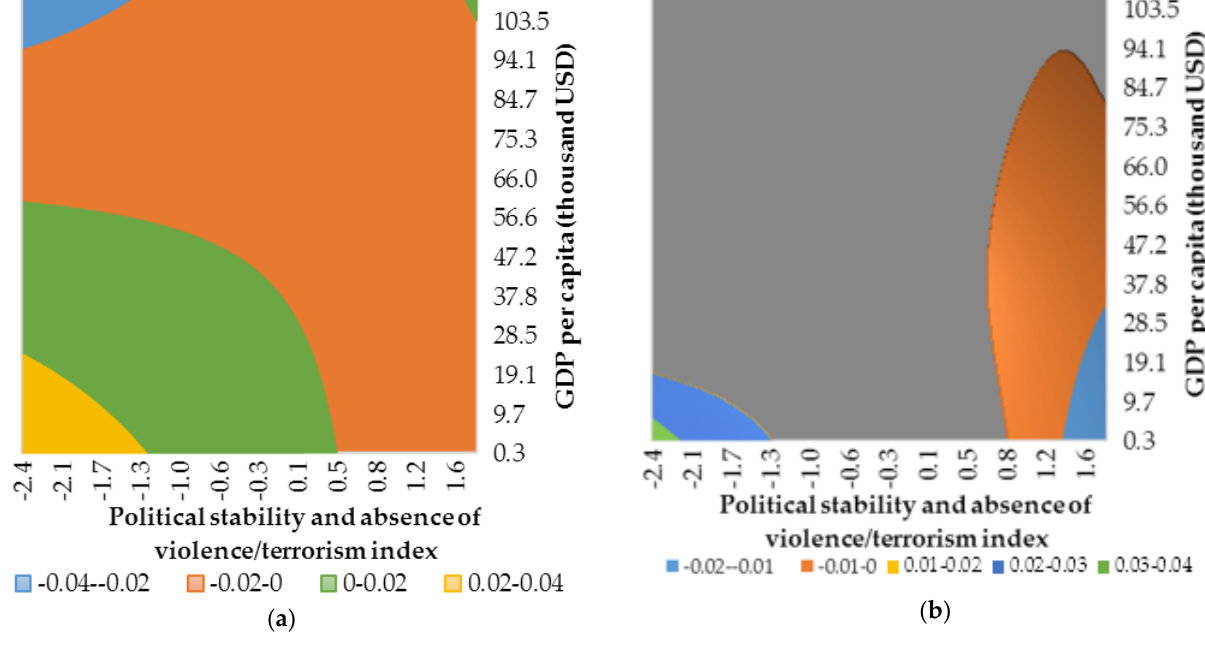
Figure A21. Conditional effect of financialisation on growth based on Est. 21 in Table A2. ( a ) Estimated conditional slope coefficient over the whole range of observed values for institutional quality and development level. ( b ) Estimated statistically significant conditional slope coefficient. Gray represents a combination of institutional quality and development level for which effect of financialisation on growth is statistically insignificant. Source: authors’ contributions.